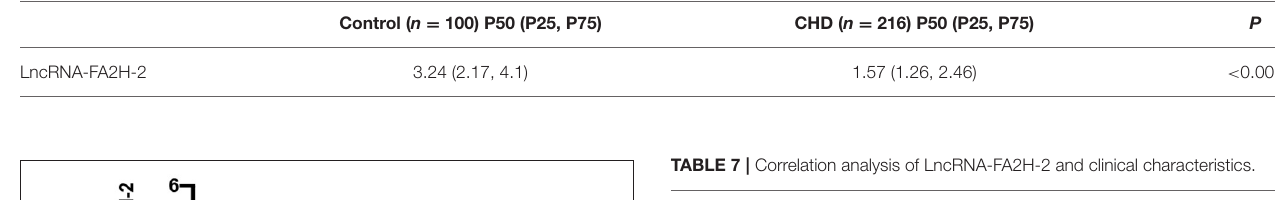
TABLE 5 | Analysis the relative expression of LncRNA-FA2H-2.